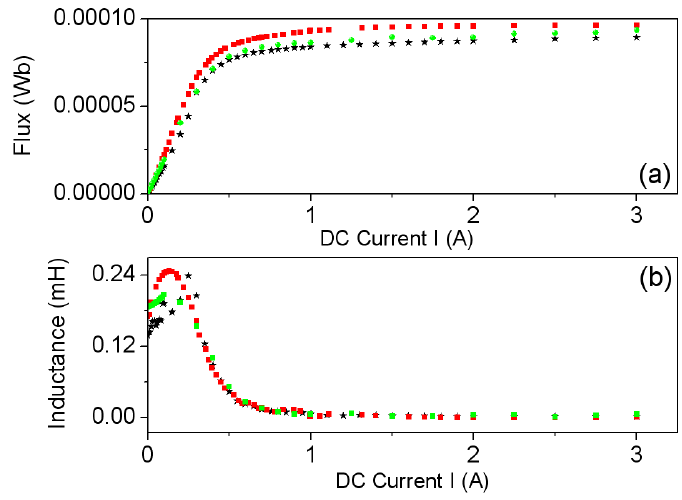
Figure 10. Results for the E20/10/5 ferrite core. ( a ) Φ - I curves and ( b ) L - I curves. Experiment ( * ), 2D simulations (  ) and 3D simulations (  ) with g = 5